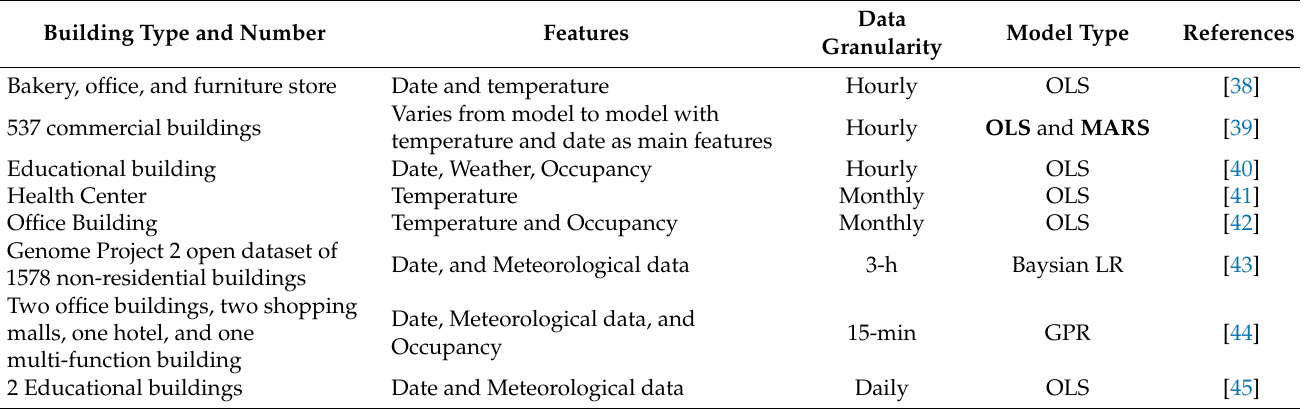
Table 2. Linear regression cases that are applicable to M&V analysis and utilize real historical